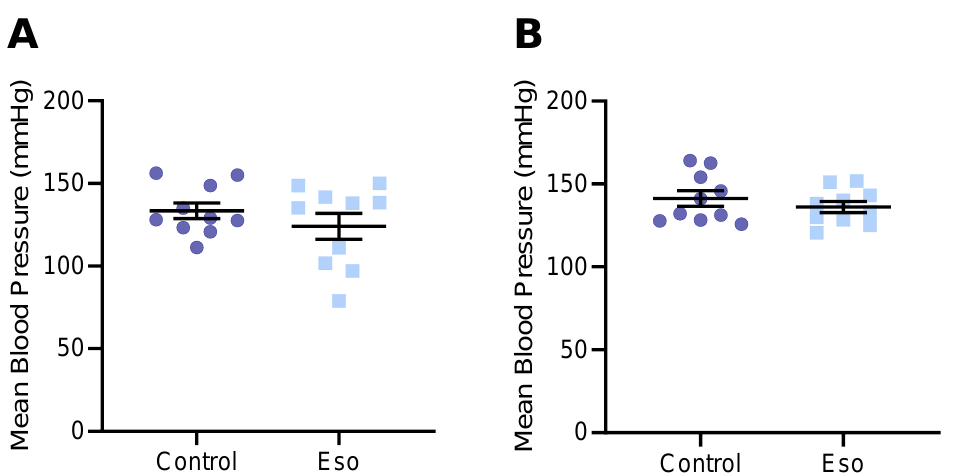
Figure 1. Effect of esomeprazole on blood pressure of lean (normal weight mice on standard chow diet) administered L-NAME in pregnancy. Mean arterial blood pressure was measured ( A ) D14.5 and ( B ) D17.5 of pregnancy via tail cuff plethysmography. Esomeprazole treatment did not alter blood pressure compared to vehicle control (no esomeprazole) at either time point. Results presented as mean ± SEM. n = 10 mice/group.